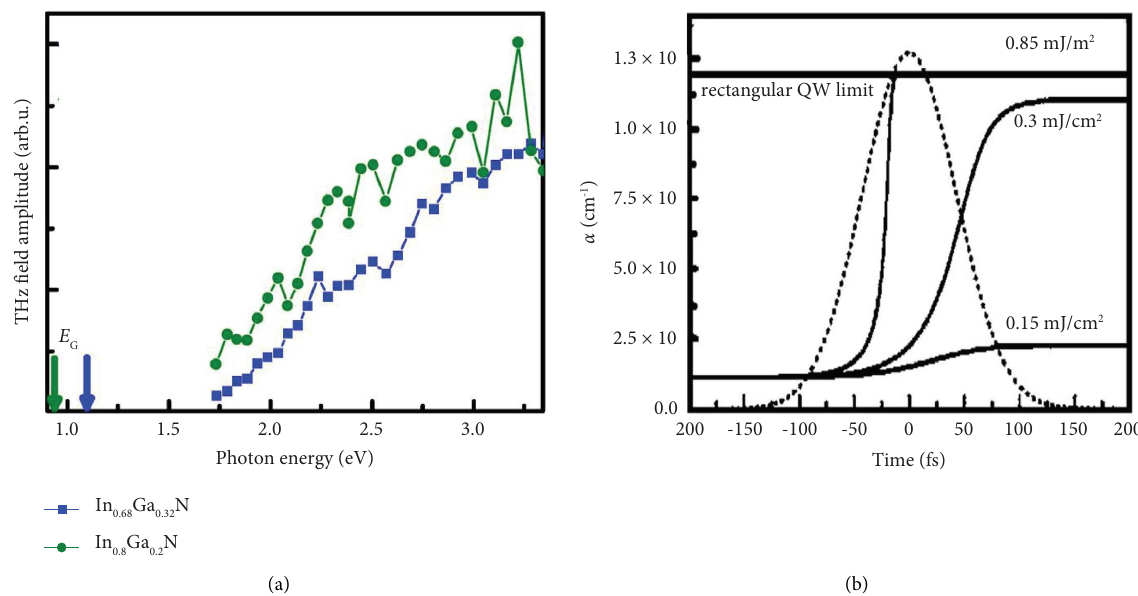
Figure 3: (a) THz feld amplitude as a function of excitation energy in In represents the doping concentration. Copyright nature portfolio (b) Temporal evolution of absorption coefcient. Te dashed line rep- resents the normalized temporal shape of the photon fux in the excitation pulse. Reproduced with permission from AIP Publishing. Copyright AIP